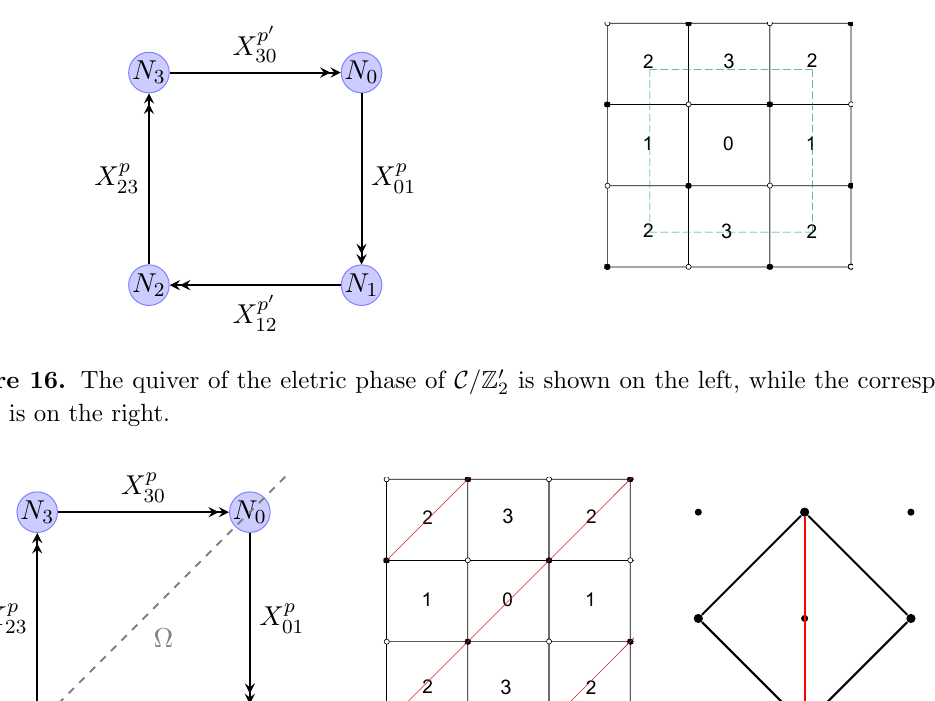
Figure 17. The orientifold involution (cid:10) of C = Z 0 on the center, while the toric diagram is shown on the